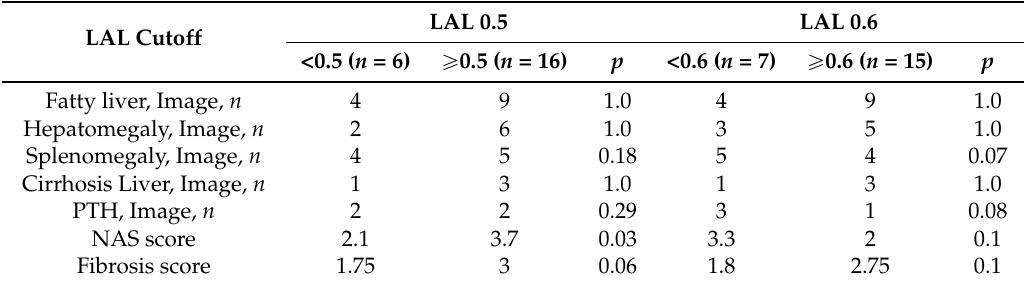
Table 5. Imaging and histologic characterization of participants according to LAL